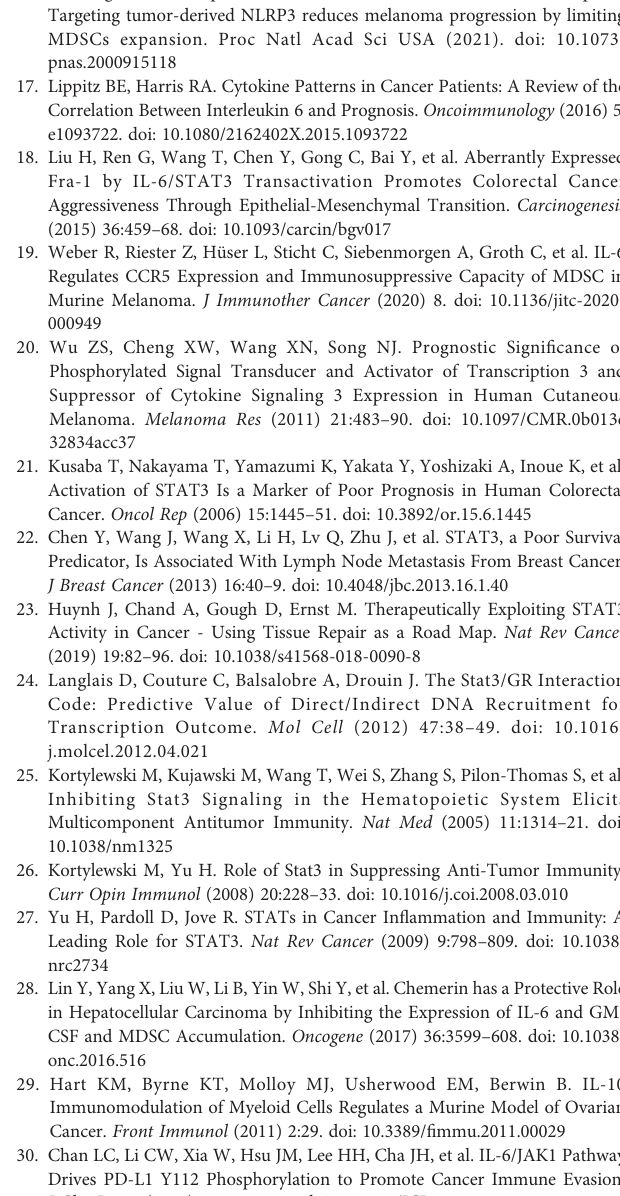
Supplementary Figure 2 | (A) Tumor growth in mice treated with saline control (Vehicle) or AZD1480 (AZD1480) (N=8/group). (B) Correlation between NLRP3 and IL ‐ 6 expression in human cutaneous melanoma (SKCM) TCGA datasets (N=363). (C) Correlation between of IL-6 and SOCS3 expression in human cutaneous melanoma (SKCM) TCGA datasets